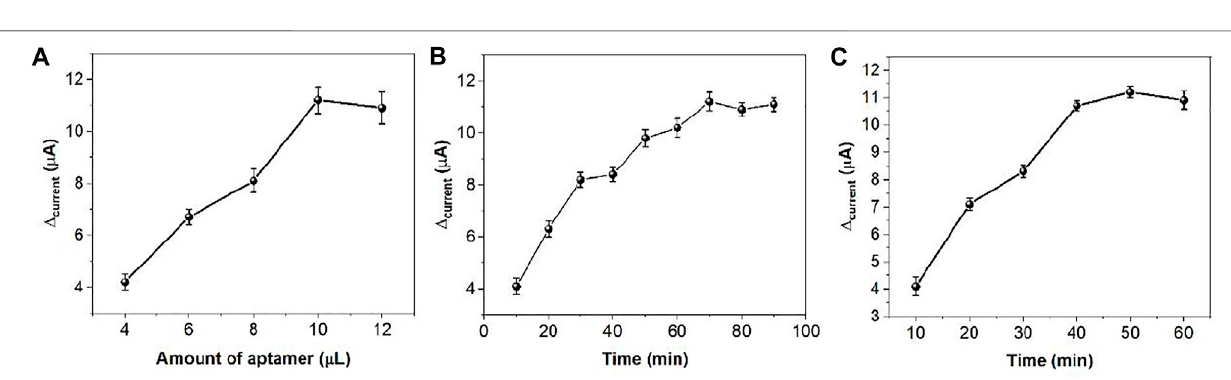
FIGURE 8 | The effect of (A) amount of aptamer, (B) hybridization time and (C) speci fi c reaction time in thrombin sensing.